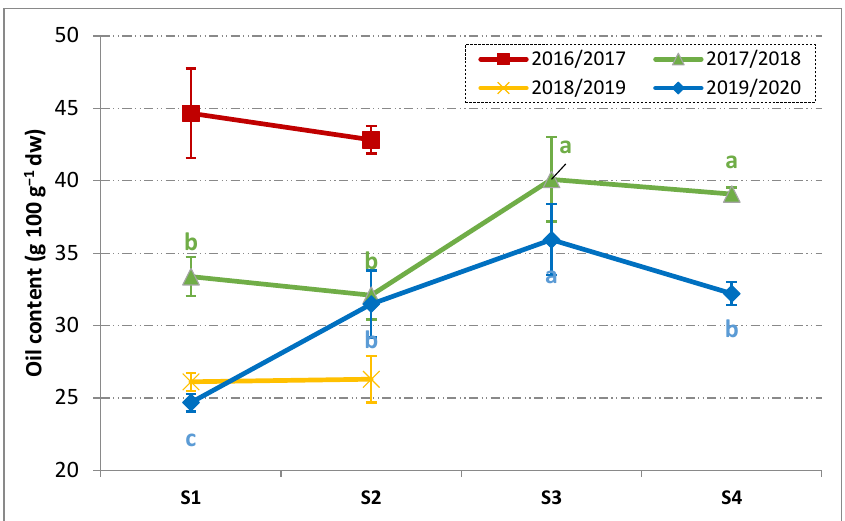
Figure 2. Oil content on dry weight (mean ± SD, n = 3) of the Oliva Rossa drupes during ripening in four consecutive harvest seasons. Different letters for each harvest year indicate significant differences according to one-way ANOVA followed by Fisher’s LSD post-hoc test (α = 0.05). S1–S4: four subsequent samplings.